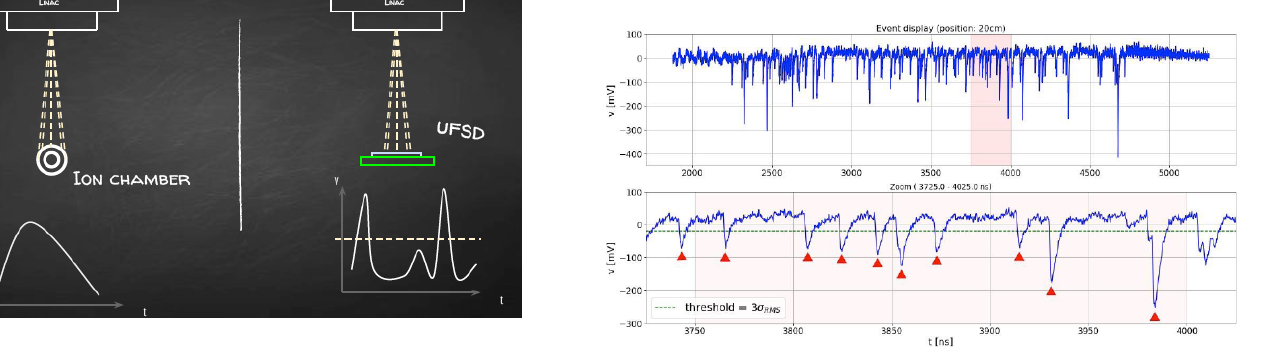
Fig. 9. Signal measured as a function of time. Each spike shows the beam delivered to a potential patient. The red area is zoomed in the bottom plot and the red triangles show the spikes that can be triggered using the Silicon